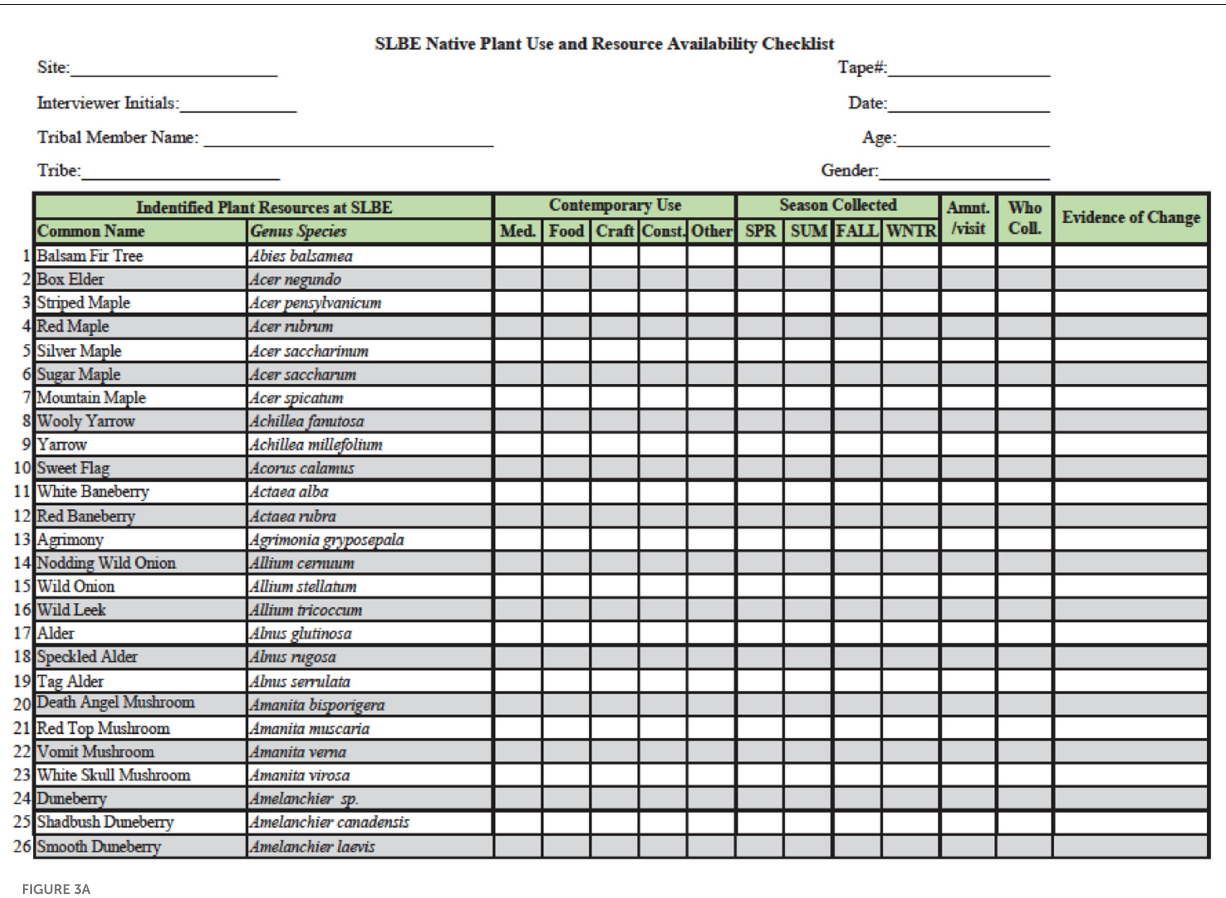
Figure 4 divides the SLBE ecology into five types of habitats that were perceived by tribal representatives to be both